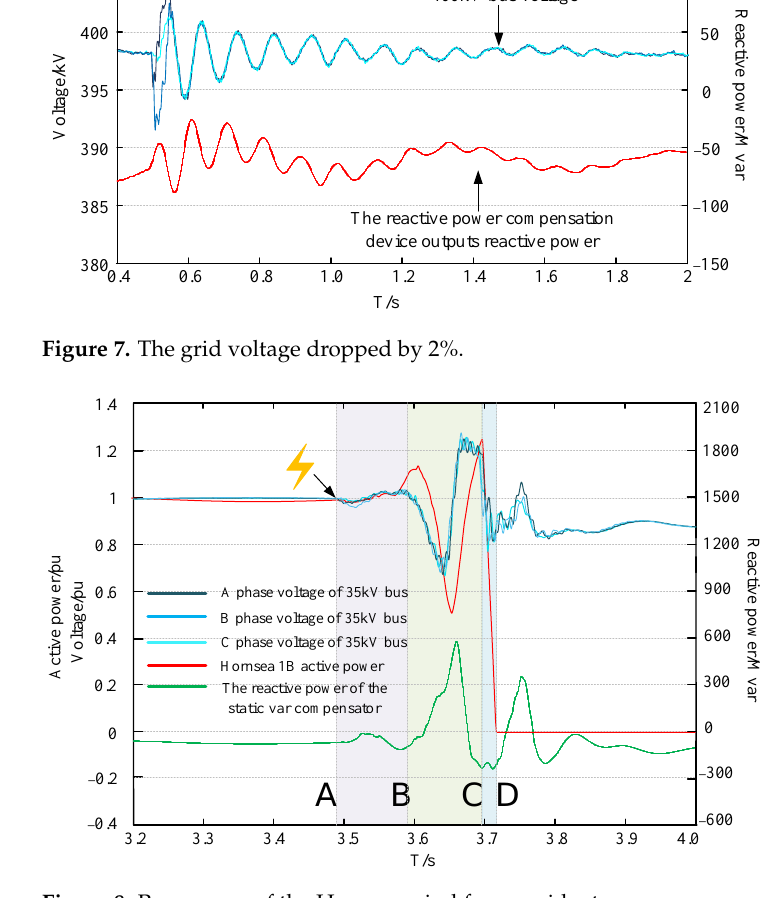
Figure 8. Recurrence of the Hornsea wind farm accident.